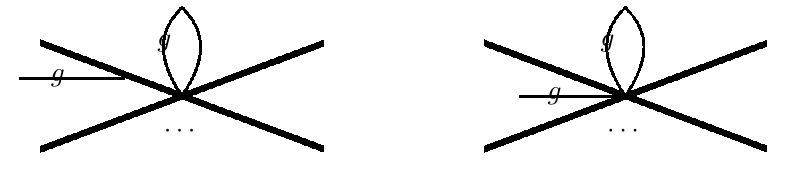
Figure 14 . Diagrams where both ends of the internal graviton attach to the n -point vertex. In dimensional regularization these diagrams vanish. Even if we use momentum cut-o(cid:11), these diagrams cannot have any contribution proportional to ln ! (cid:0) 1 since the soft momentum k does not (cid:13)ow through any